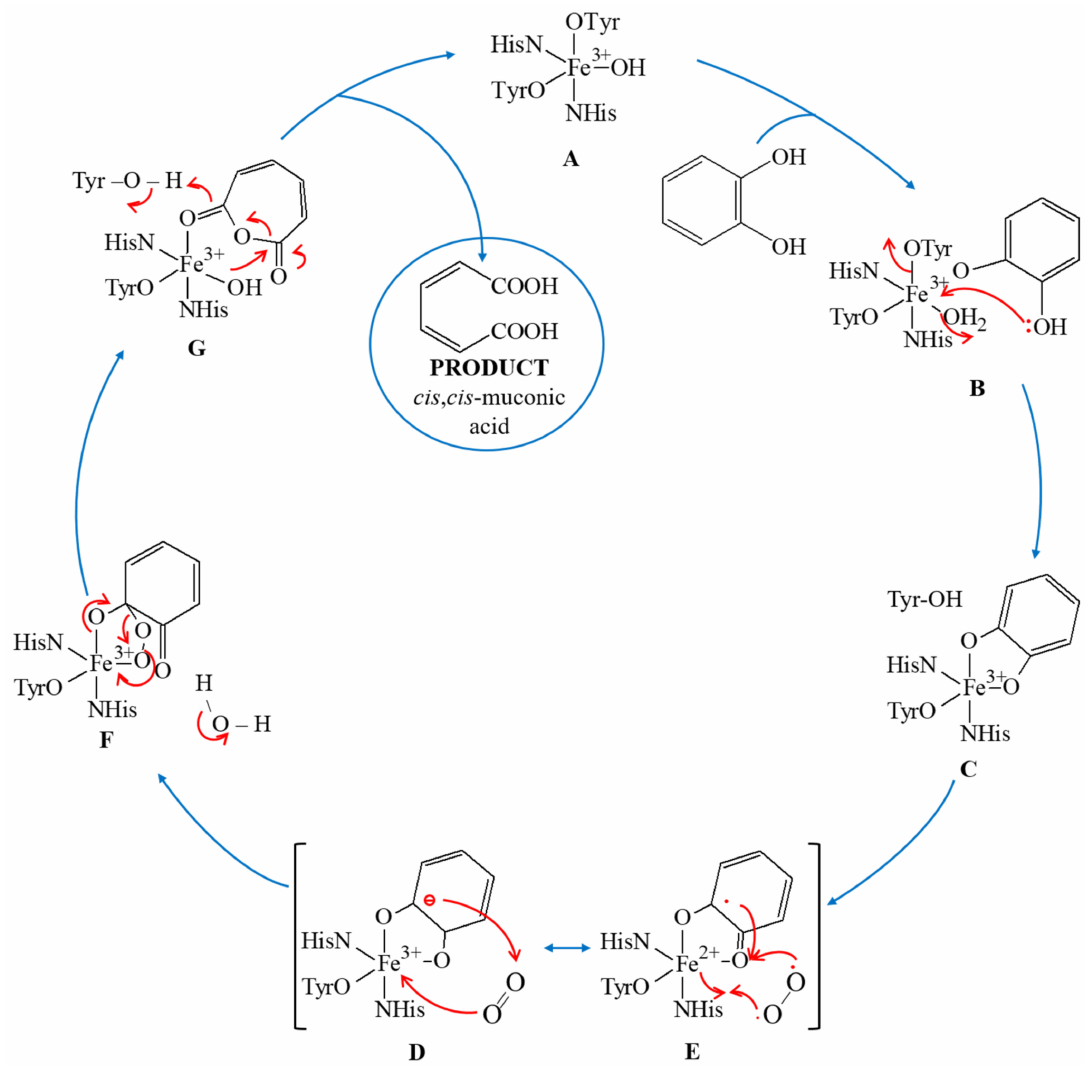
Figure 3. The overall mechanism of intradiol catechol deoxygenation catalyzed by